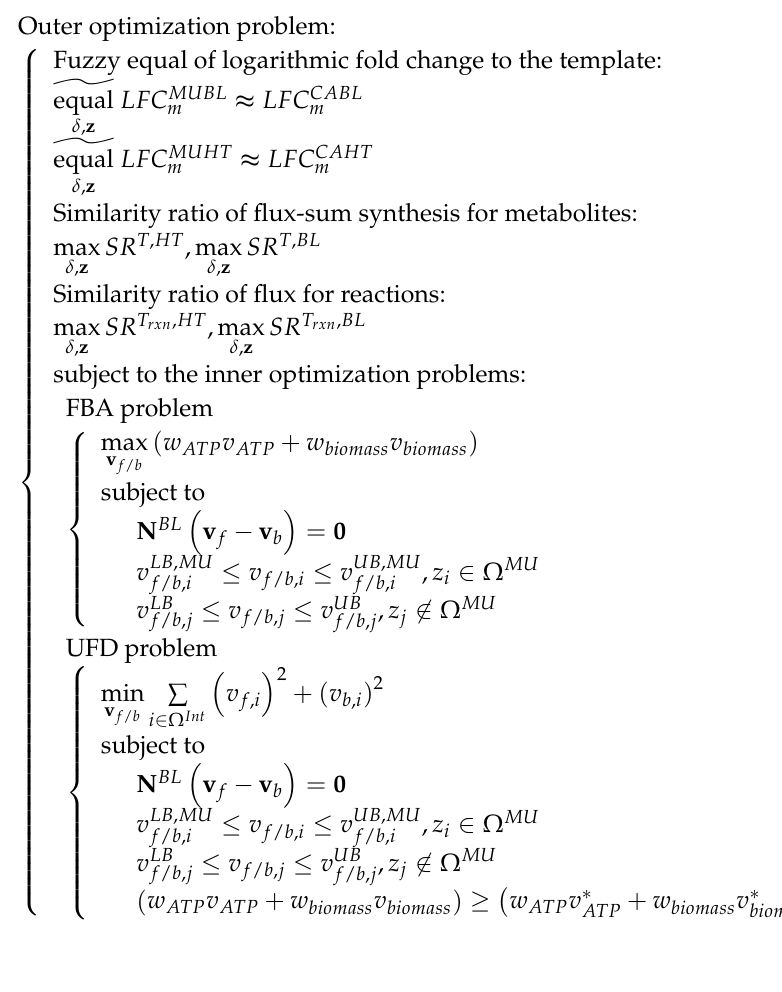
Figure 2. Flowchart of the in silico experiment for inferring oncogenes. ( A ) Reconstruct the cancer and normal models. ( B ) Compute the flux distributions of cancer and normal models. ( C ) Build the flux template according to the flux distributions of cancer and normal models. ( D )–( I ) Simulation of a wet lab experiment for determining oncogenes. Orange arrows indicate the building processes of the flux template that acted as the control in the oncogene inference problem. Red arrows present the mutant schemes for formulating the tri-level oncogene inference